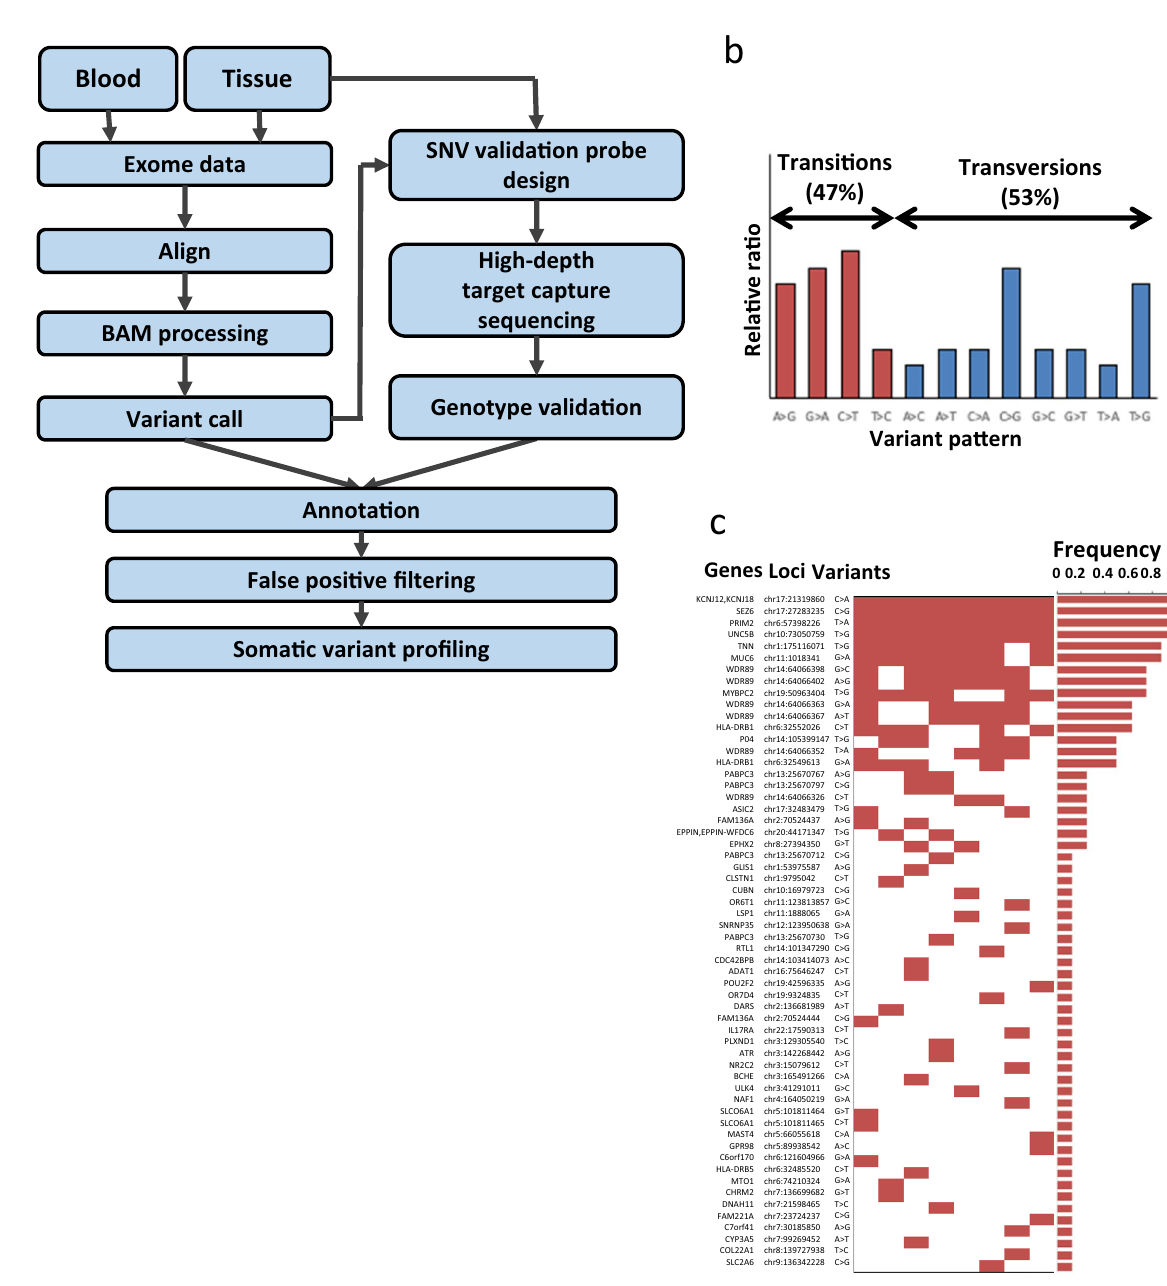
Figure 2. Somatic variant profiles of the discovery cohort. ( a ) Analysis pipeline used for whole-exome sequencing (WES) data (drawn in Microsoft 365 Powerpoint). ( b ) Relative ratio of transition and transversion variants (created in Microsoft 365 Excel; https:// www. micro soft. com/ ko- kr/ micro soft- 365). ( c ) Somatic variant profiles of the eight tissue-derived samples. Genes were sorted in descending order of frequency. The profile of the FFPE-derived sample was not plotted because of the low quality of the sequencing data. NGDN (p.S79C) confirmed by Sanger sequencing was considered the target of the validation cohort (created in Microsoft 365